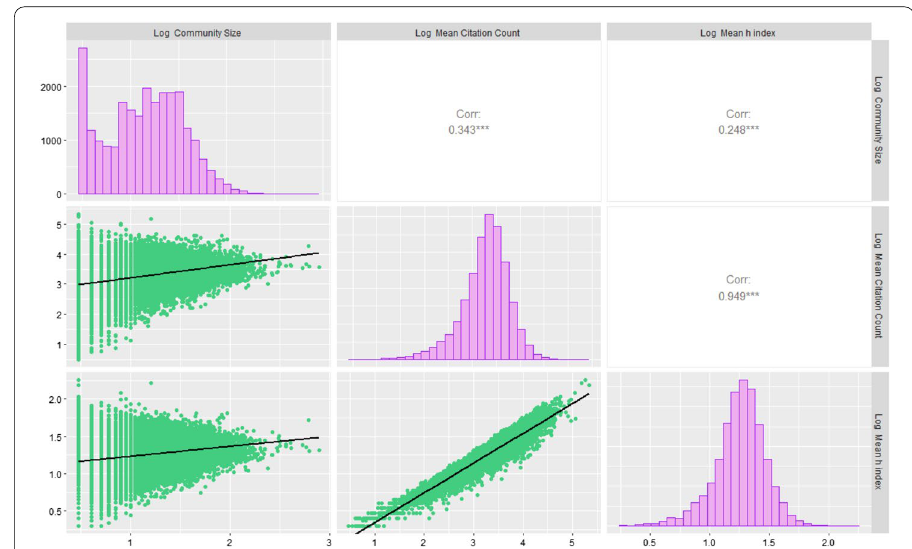
Fig. 3 Bivariate relationships between communities’ attributes